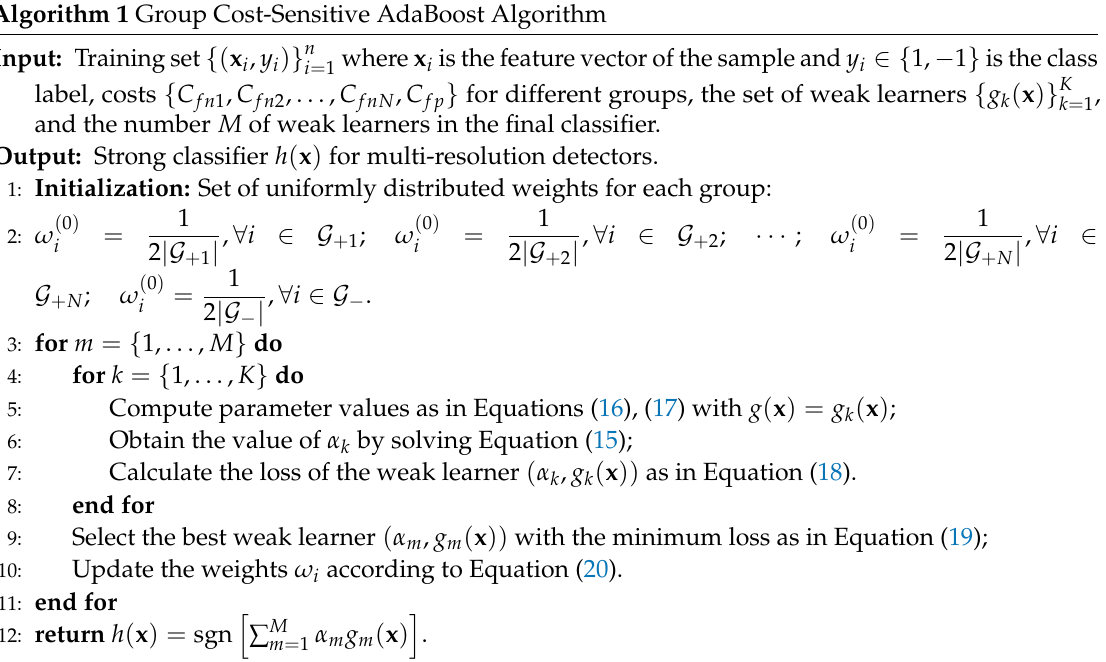
Algorithm 1 a summary of the proposed group cost-sensitive AdaBoost algorithm. Algorithm 1 Group Cost-Sensitive AdaBoost